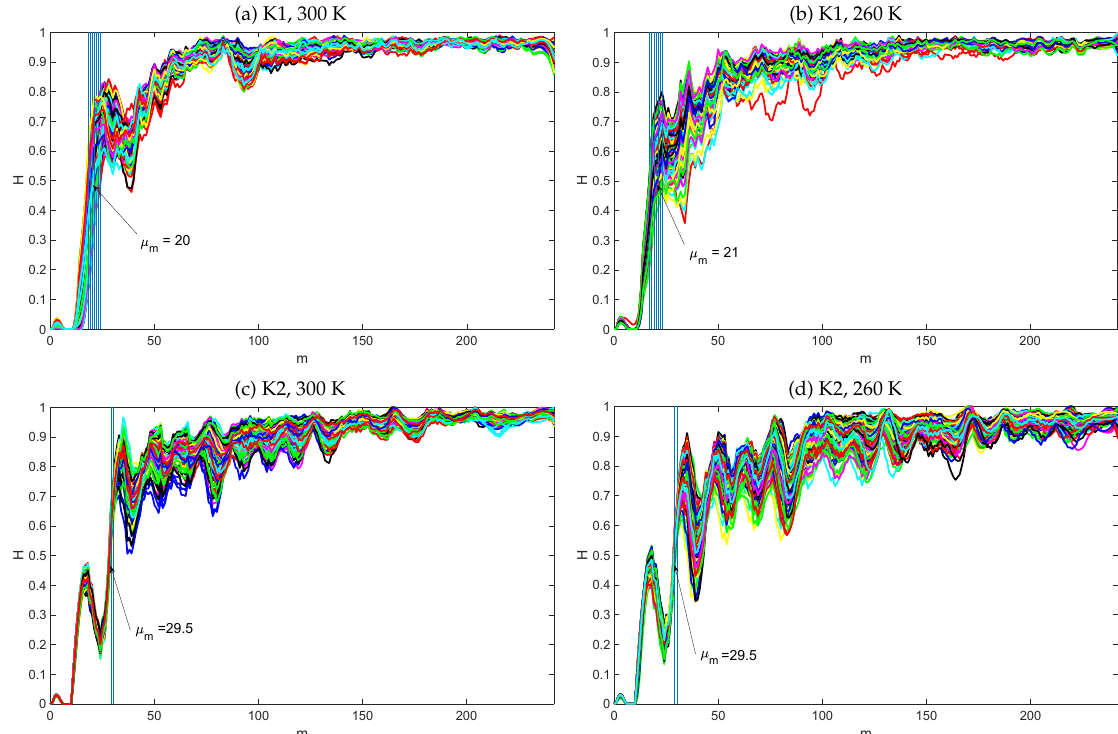
Figure 12. Example entropy vs. m relationships (100 circuit runs) of two circuits K1 ( a , b ) and K2 ( c , d ) at 300 K ( a , c ) and at 260 K ( b , d